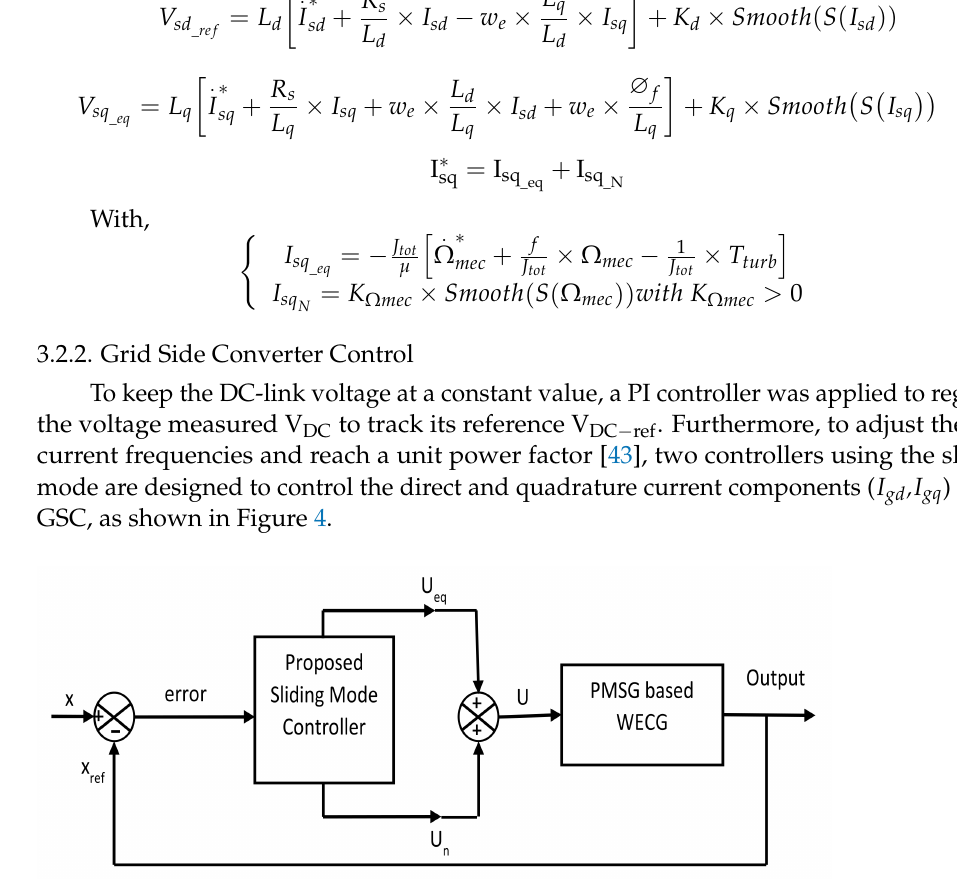
Figure 4. The general structure of the